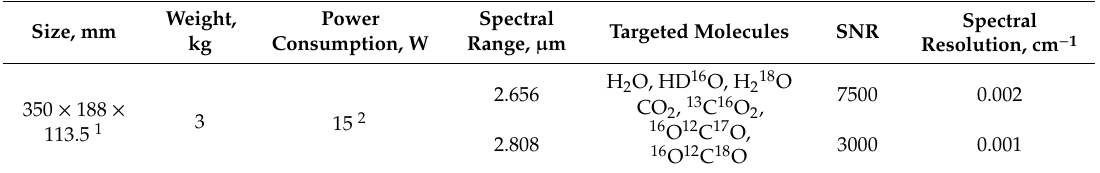
Table 1. Technical parameters of the